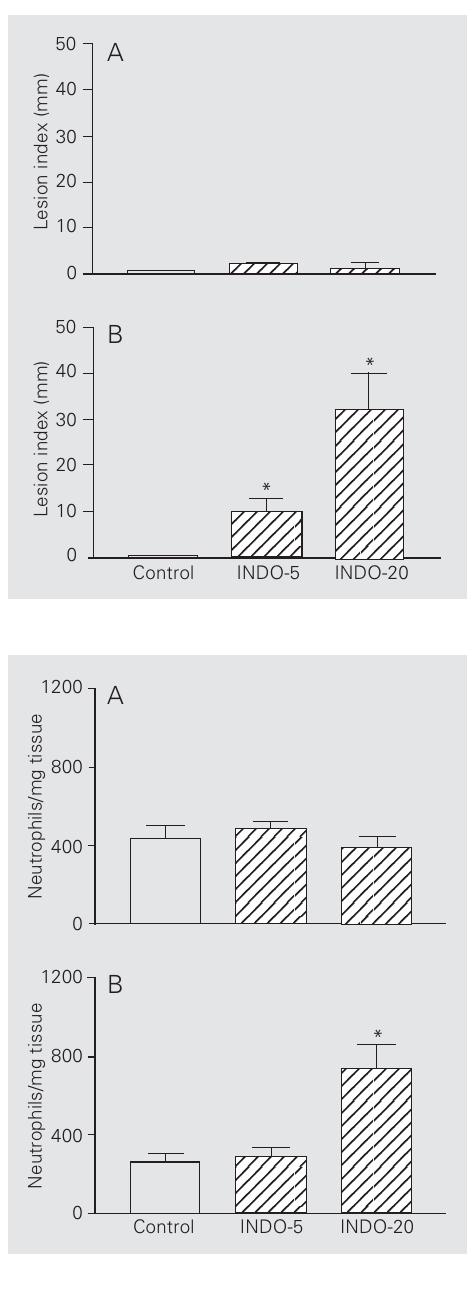
INDO-20Figure 1. Gastric mucosal dam- age in rats treated with 5 or 20 mg/kg indomethacin (INDO-5 or INDO-20) or vehicle (control). Af- ter 1 h (panel A) or 3 h (panel B), animals were killed and the le- sion index (mm) was calculated. Data are reported as the mean ± SEM for N = 5. *P < 0.05 com- pared to control (ANOVA fol- lowed by Newman-Keuls